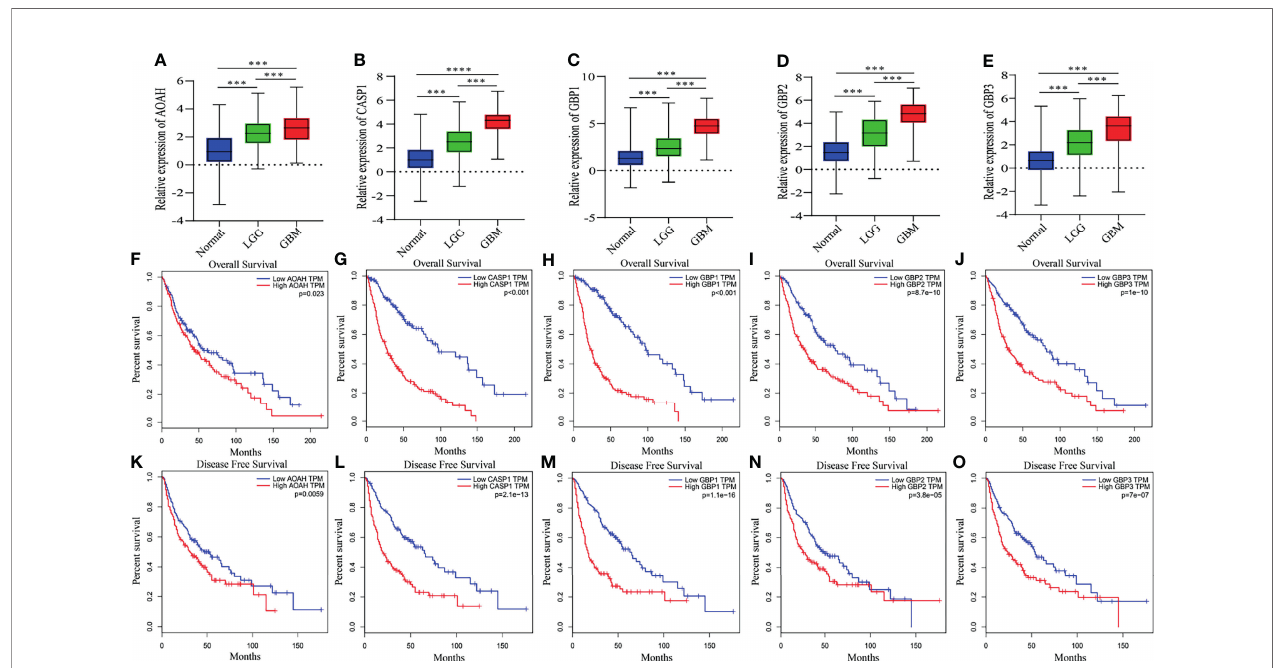
FIGURE 7 | Differential expression, OS and DFS of fi ve pyroptosis-related genes. (A – E) Boxplots showing the relative expression levels of AOAH (A) , CASP1 (B) , GBP1 (C) , GBP2 (D) and GBP3 (E) in normal brain tissues, low-grade glioma tissues and GBM tissues. *** p < 0.001 and **** p < 0.0001. (F – O) Survival curves for OS and DFS in glioma patients with high expression and low expression of the following genes: AOAH (F, K) , CASP1 (G, L) , GBP1 (H, M) , GBP2 (I, N) and GBP3 (J, O)